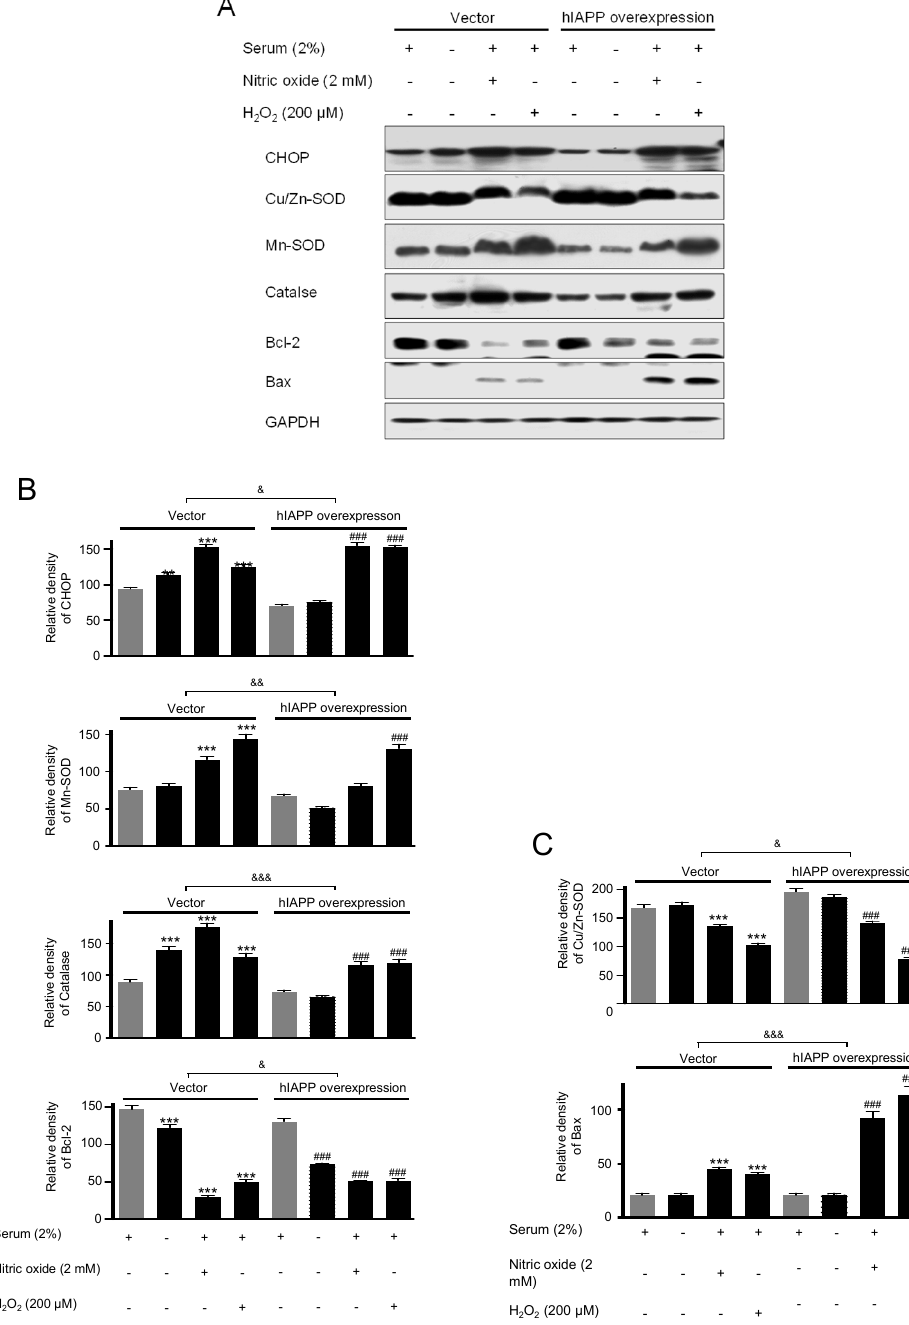
Figure 7. The expressions of CHOP, Cu/Zn-SOD, Mn-SOD, catalase, Bcl-2, and Bax proteins in pCMV-Entry-expressing cells and INS1E-hIAPP-overexpressing INS-1E cells under oxidative stress conditions. INS-1E cells were incubated in RPMI 1640 medium supplemented with/without 2% fetal bovine serum and/or nitric oxide (2 mM) or hydrogen peroxide (200 μ M) for 24 h at 37 °C with 5% CO 2 . CHOP, Cu/Zn-SOD, Mn-SOD, catalase, Bcl-2, and Bax were then analyzed by Western blot ( A ). The relative amounts of CHOP, Mn-SOD, catalase, and Bcl-2 ( B ) and Cu/Zn -SOD, and Bax ( C ) were quantified as described in Materials and Methods. Data represent the mean ± SEM of three experiments. *** p < 0.001 vs. 2% FBS in pCMV-Entry-expressing cells; ### p < 0.001 vs. 2% FBS in INS1E-hIAPP-overexpressing cells; & p < 0.05, && p < 0.01, &&& p < 0.001, pCMV-Entry-expressing cells vs. INS1E-hIAPP-overexpressing cells.